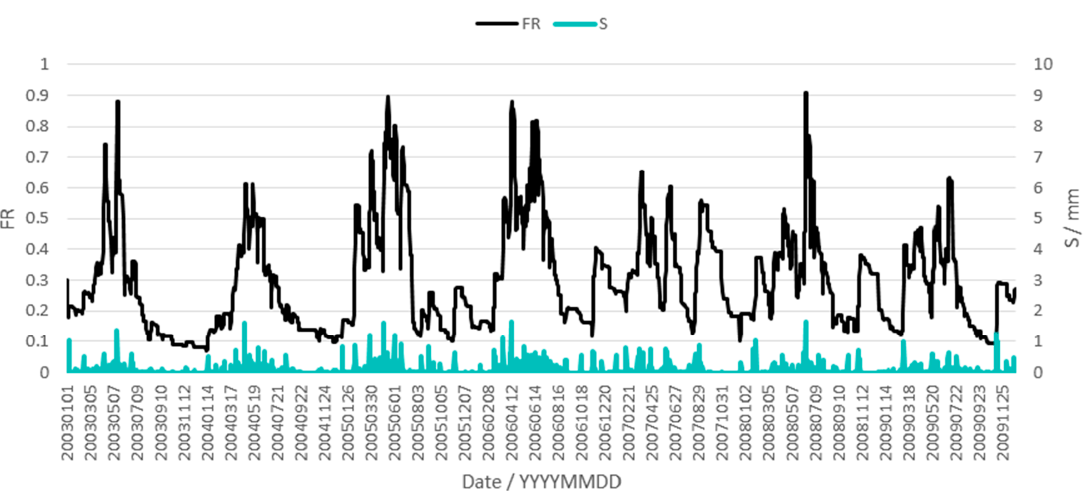
Figure 11. Simulated areal mean runoff generation area and free water storage of the CREST 3.0 model.